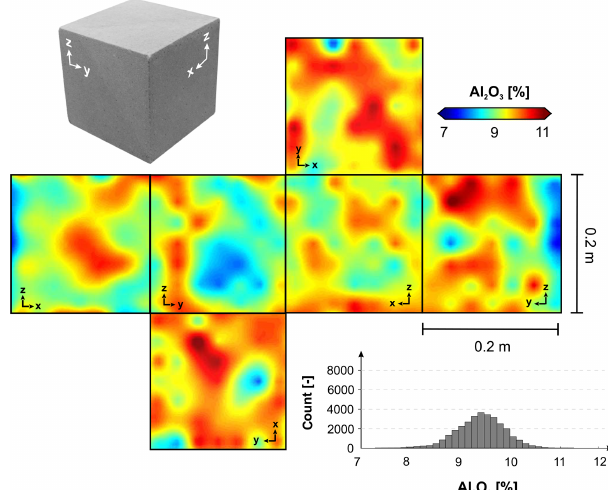
Figure 11. Spatial distribution of the mass fraction of Fe 2 O 3 mod- eled with a simple kriging interpolation. As in the intrinsic perme- ability interpolation, a bimodality can be observed in the empirical histogram.